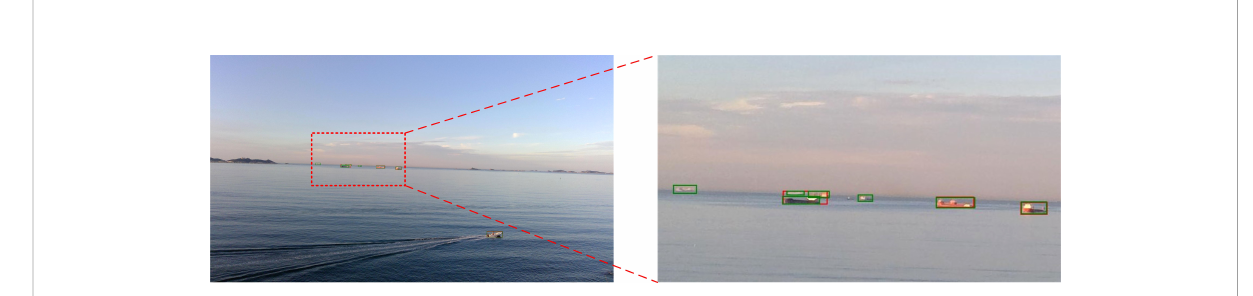
FIGURE 5 The detection result on the WSODD dataset. The red and green bounding boxes represent the detection results of the baseline and our model,